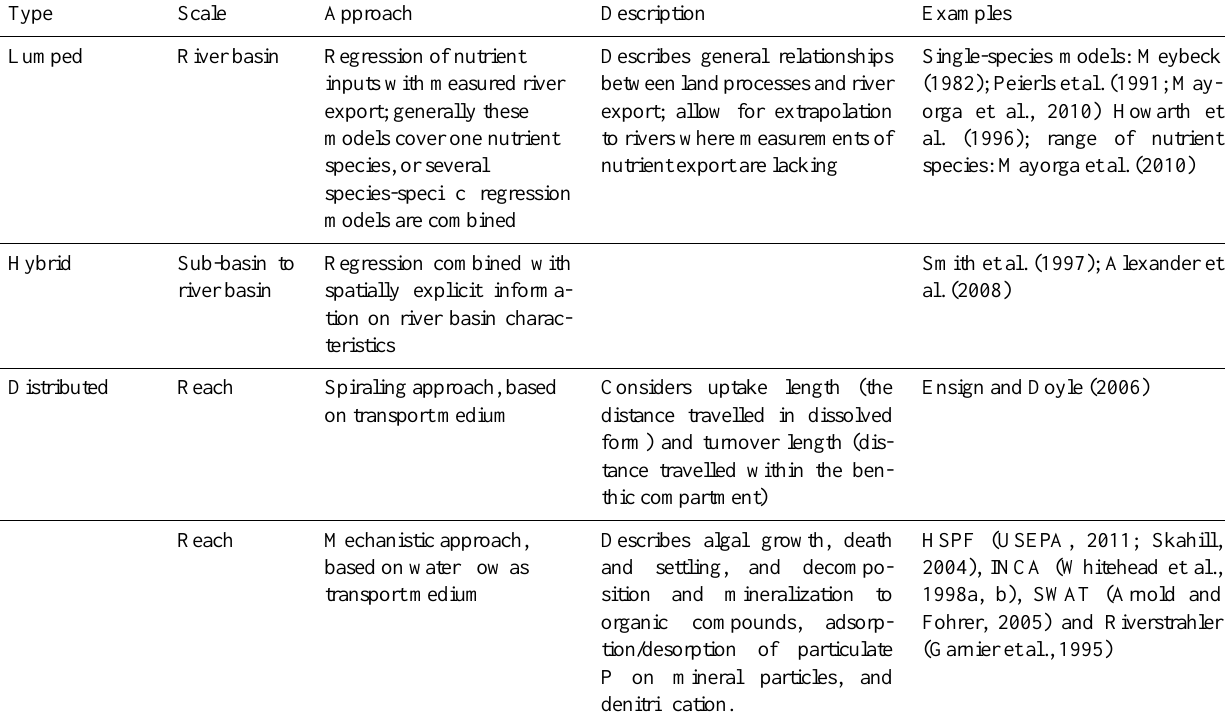
Table 3. Examples of available approaches for describing nutrient transport from land to sea through